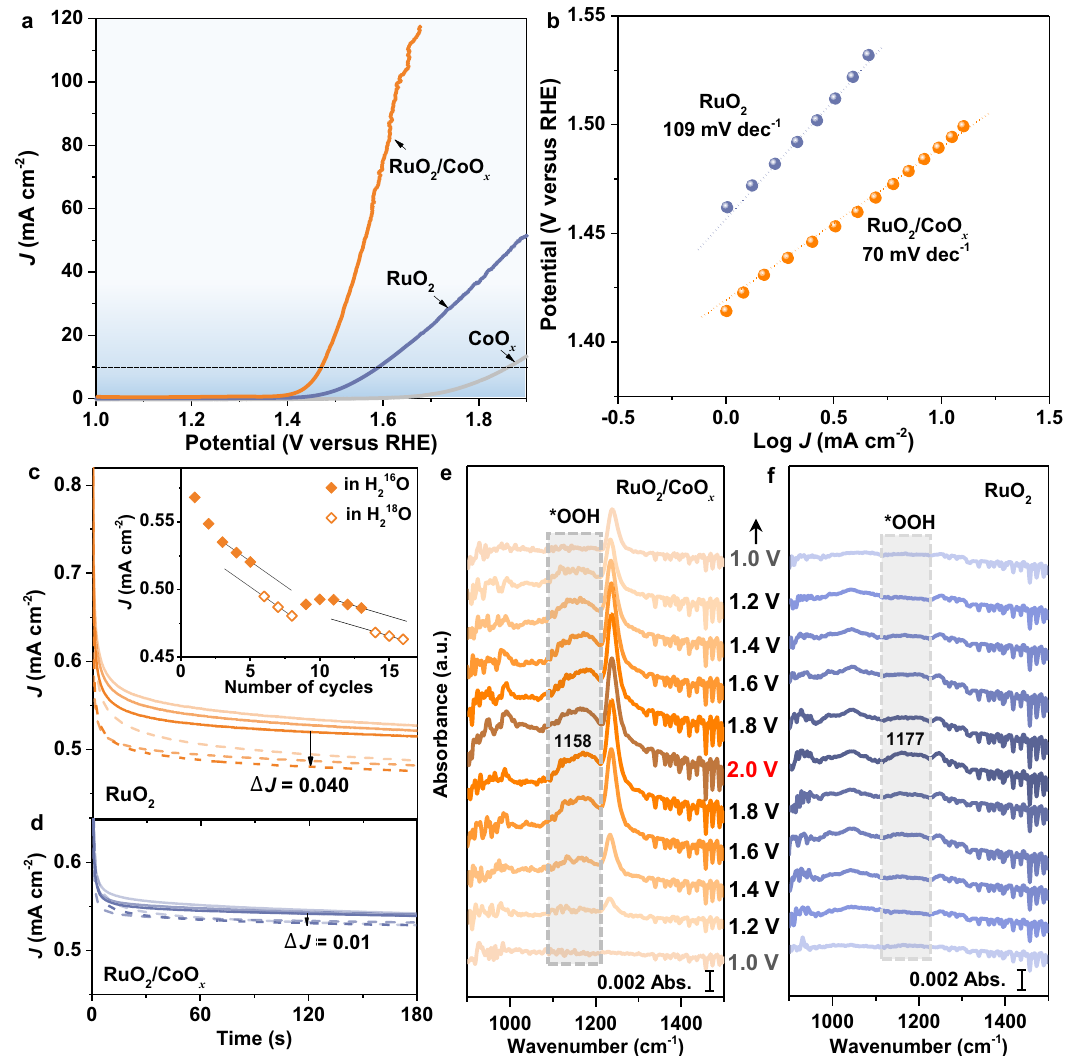
c representstheaveragecurrentdensity( J average )duringthelast2minutesforeach cycle. e , f In situ surface-enhanced IR spectra of RuO 2 /CoO x and RuO 2 at different potentials.ThepotentialswerereferencedtoRHE.Notethatthecatalystsherewere tested in neutral electrolyte and the RuO 2 loading on CoO x is 10 µ g on per cm 2